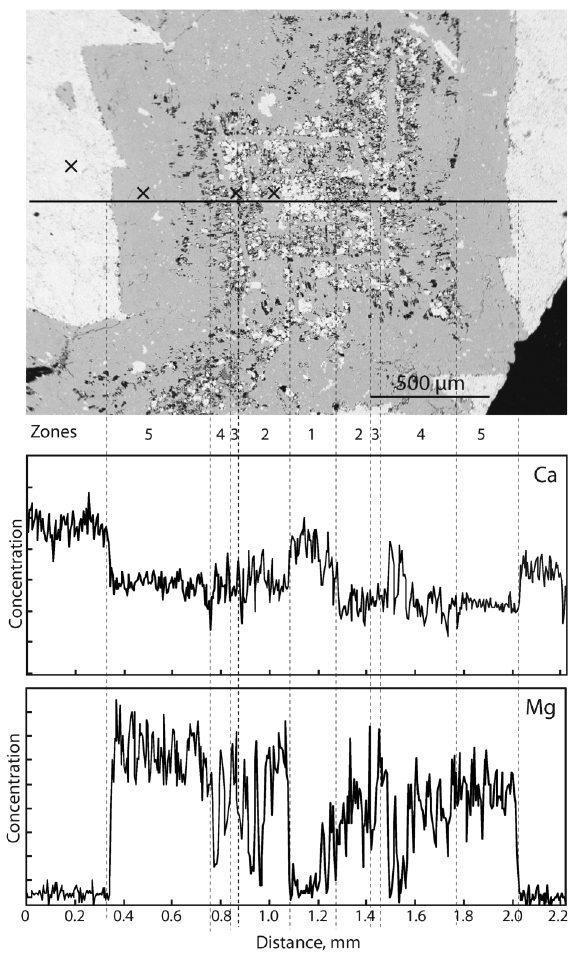
Fig. 9. Extremely variable concentrations of Ca and Mg along the transect line across the concentric zoned dolomite rhomb of type 3 analysed with the electron microprobe. The determined zones correspond to the zonation discussed in the text. The places of point analyses are marked with crosses. Hino drill core, 45.8 m, GIT 441-637.